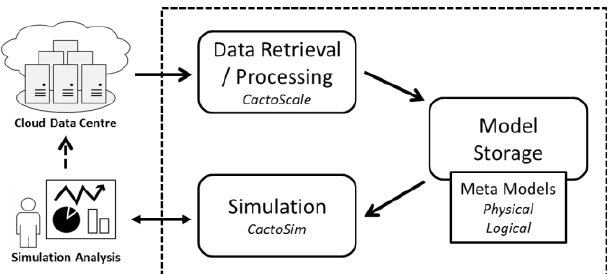
Figure 2. Route of data towards automated simulation model